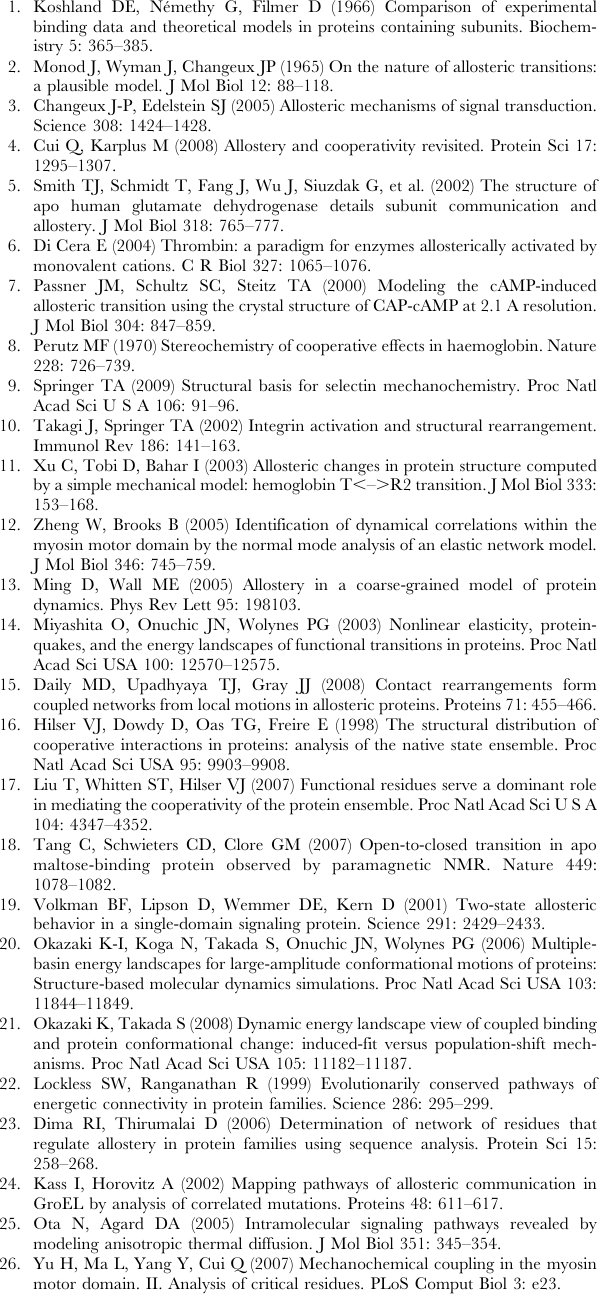
structures. Corresponding plots for CheY, the a L I-domain, and Ras are presented in Figure 1. Table S1 Comparison between subregions that change most between conformational states Found at: doi:10.1371/journal.pcbi.1000484.s002 (0.03 MB DOC) Table S2 Description of rmsd calculations on secondary structure elements-sheets and helices-for CheY, a L I-domain, and